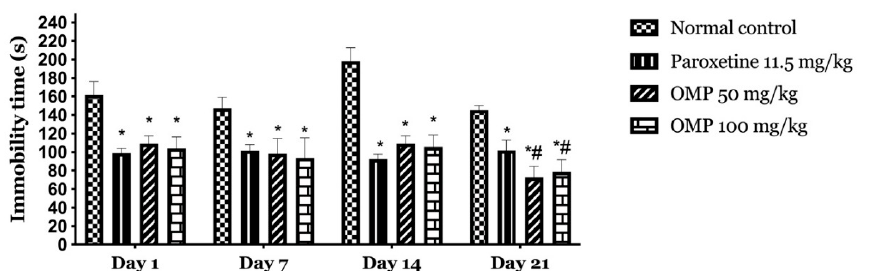
Figure 1. Temporal effects of Origanum majorana L. polyphenols (OMP) on immobility time in the tail suspension test (TST). Values are expressed as mean ± standard error of the mean (SEM). The analysis was done using two-way repeated-measures analysis of variance followed by the Tukey post-hoc